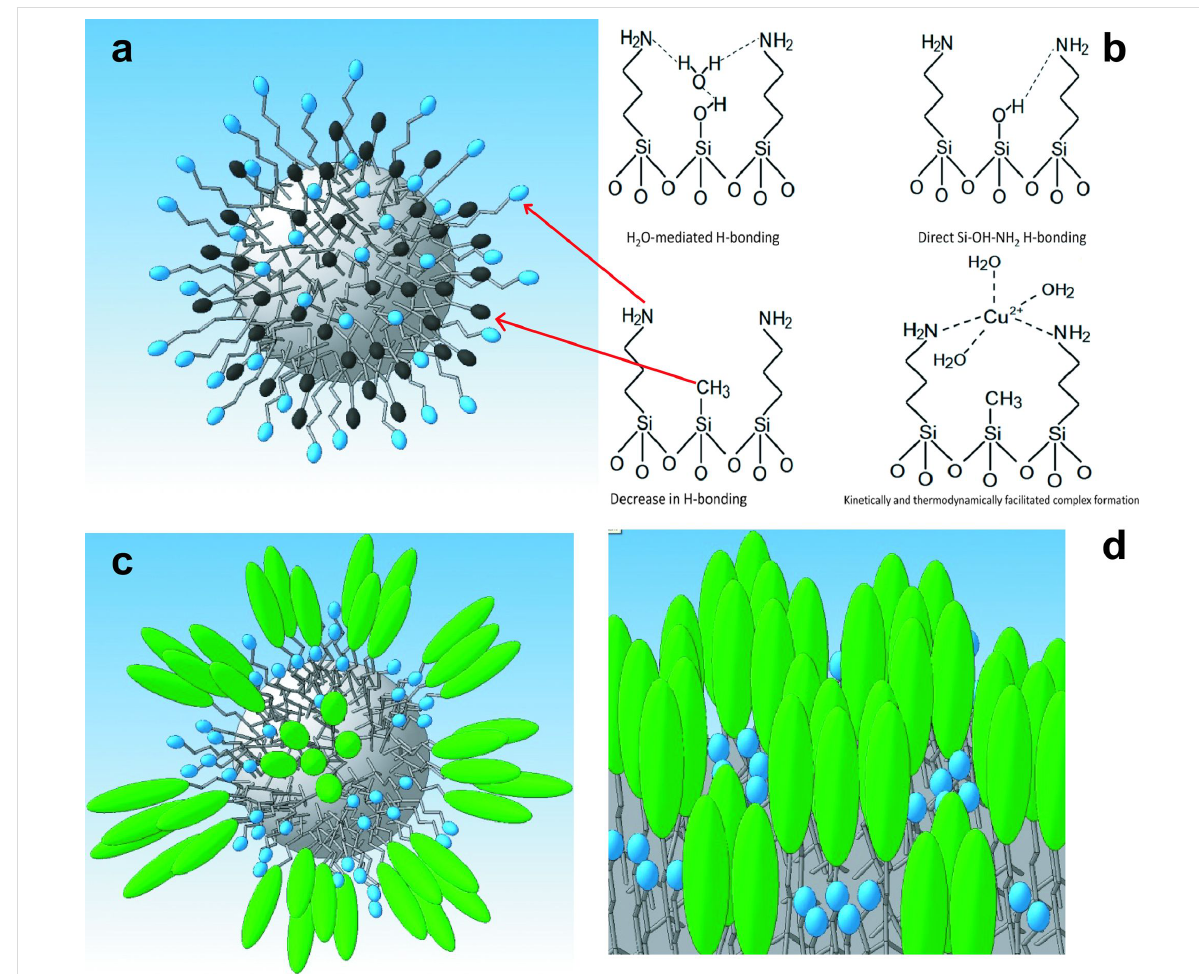
Figure 9: а ) Proposed structure of the surface layer on the of bifunctional silica particles bearing methyl and aminopropyl groups (in the image chains with black and blue headgroups, respectively); b) scheme of molecular interactions in the monofunctional layer bearing aminopropyl groups and the bifunctional layer with aminopropyl and methyl groups; c,d) proposed surface structure of the bifunctional layer for particles bearing perfluoroctyl and aminopropyl (in the image chains with green and blue head groups, respectively) groups on the